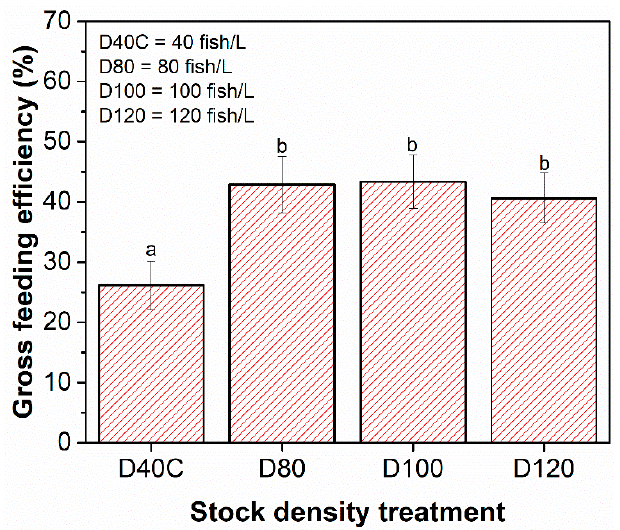
Figure 8. Gross feeding efficiency (GFE) of striped catfish ( Pangasianodon hypophthalmus ) larvae at various stock density treatment levels in exogenous stage, at mean temperature of 27 °C. Vertical bars indicate standard error. Different letters denote significant differences between groups ( p < 0.05).